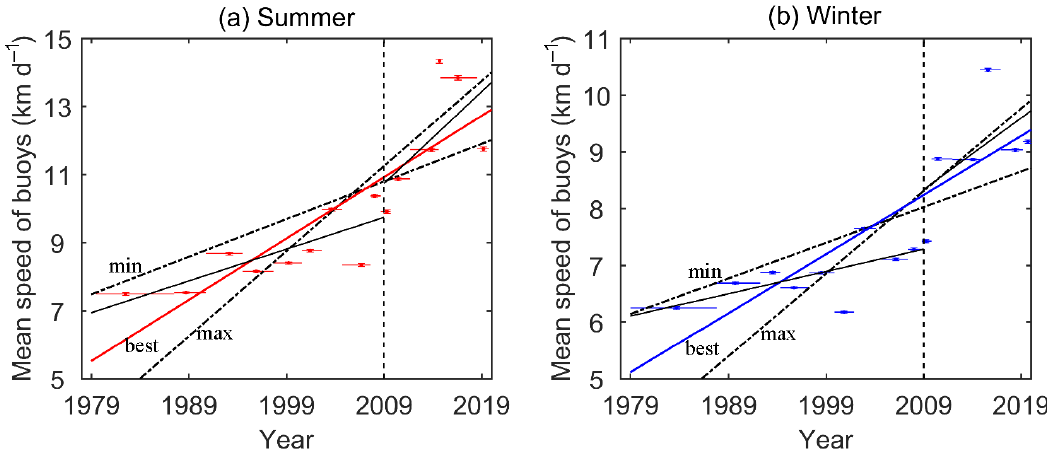
Figure 3. Multi-annual variation of sea ice drift speed U(t) in ( a ) summer and ( b ) winter from January 1979 to December 2019. For each season, the data is equally divided into 15 successive bins. The mean value and error of each bin are independently estimated. The horizontal line represents the time span of each bin. The increasing rates (in the least square sense weighted by the errors) for 1979 – 2019, 1979 – 2008 and 2009 – 2019 are shown in each panel. The black dotted lines are error bounds of the rates for 1979 – 2019. Table 1. Trends of sea ice drift speed in the Arctic Ocean obtained from this study and previous works.